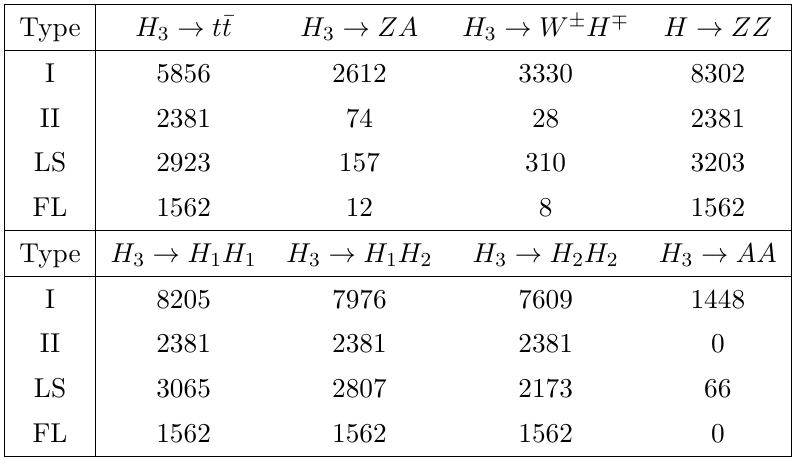
Table 23 . Number of parameter points available for the analysis in the individual OS decay channels of the non-SM-like Higgs boson H 3 ( H 2 is SM-like). points available, (cf. eq. (4.6)), for the individual OS channels to the values listed in